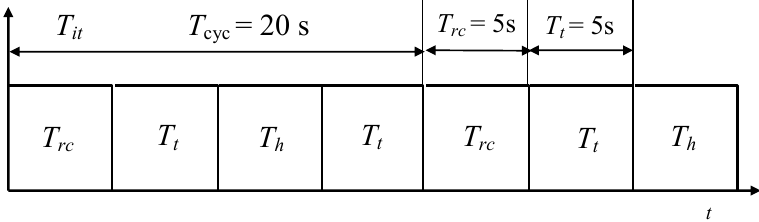
Fig. 1. Information frame